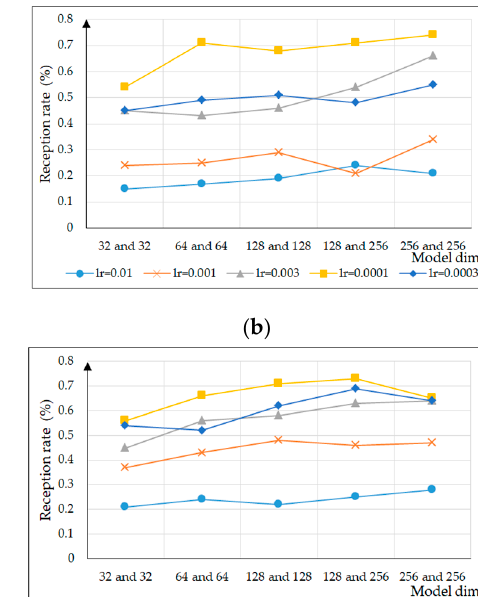
Figure 9. Comparison of super parameter selection in the model under different ( b ) τ = 0.5; ( c ) τ = 0.6; ( d ) τ =